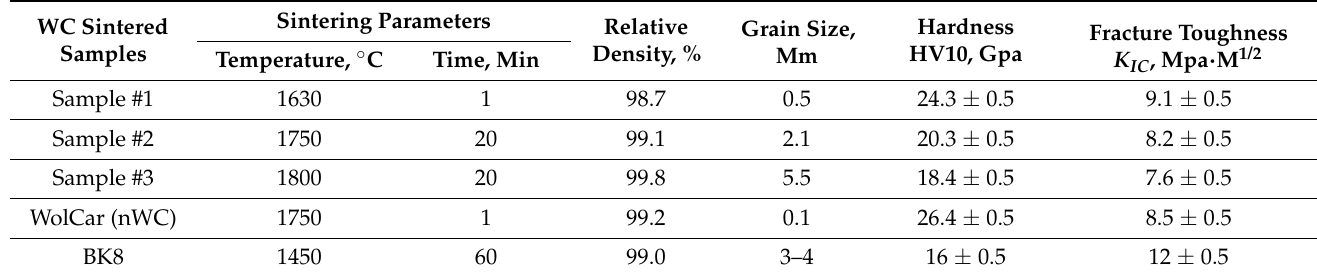
Table 2. Characteristics of the WC samples sintered at different parameters from the submicron powders (samples #1–3), nanopowder (nWC), and cobalt binder (BK8).